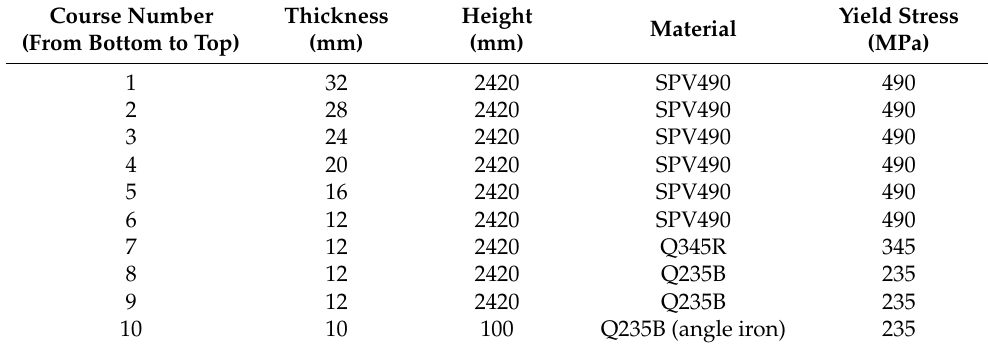
Table 1. The geometry and materials of the 100,000 m 3 tank.